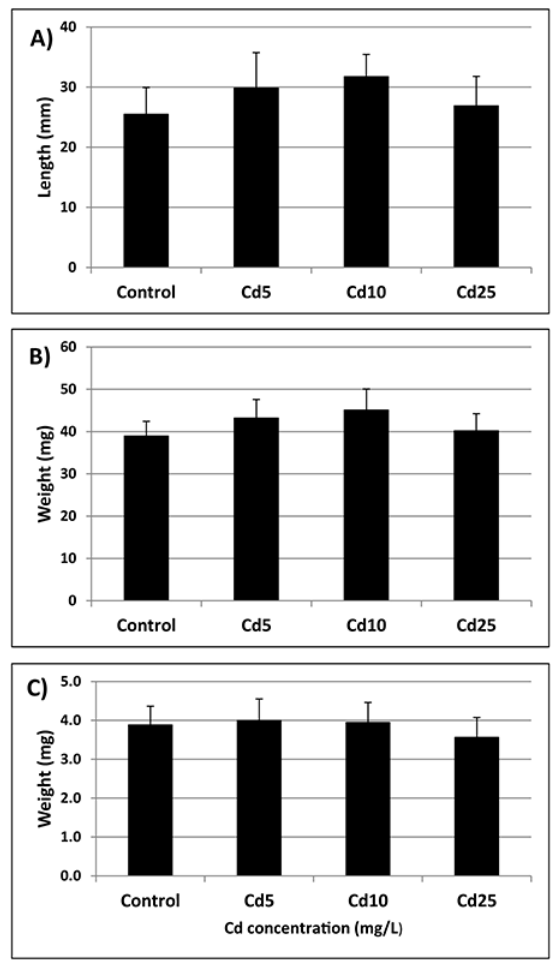
Figure 6 Root length ( A ), fresh weight ( B ), and dry weight ( C ) of seedlings grown from seeds preincubated in Cd solution with Cd at concentrations of 5 (Cd 5), 10 (Cd 10), and 25 (Cd 25) mg/Lmeasured after 72 hr of germination. The results are means of five independent repetitions ± SE . No significant differences were